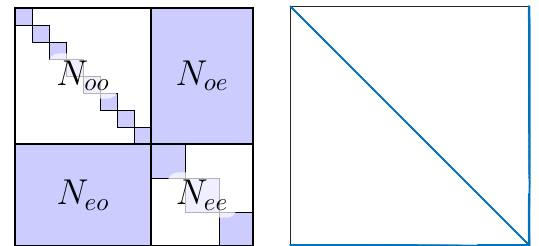
Figure 2: If the object points are ordered first, the normal ma- trix forms an arrowhead matrix, where the N oo block forms the shaft of the arrow, and the remaining blocks form the tip at the lower and right borders of the matrix (left). The arrow- head shape is more clear for real projects, where the number of OP make the N oo block dominate the matrix. The right figure shows the normal matrix for the ROMA data set (see Section 4.1) with 60 images and about 25000 object